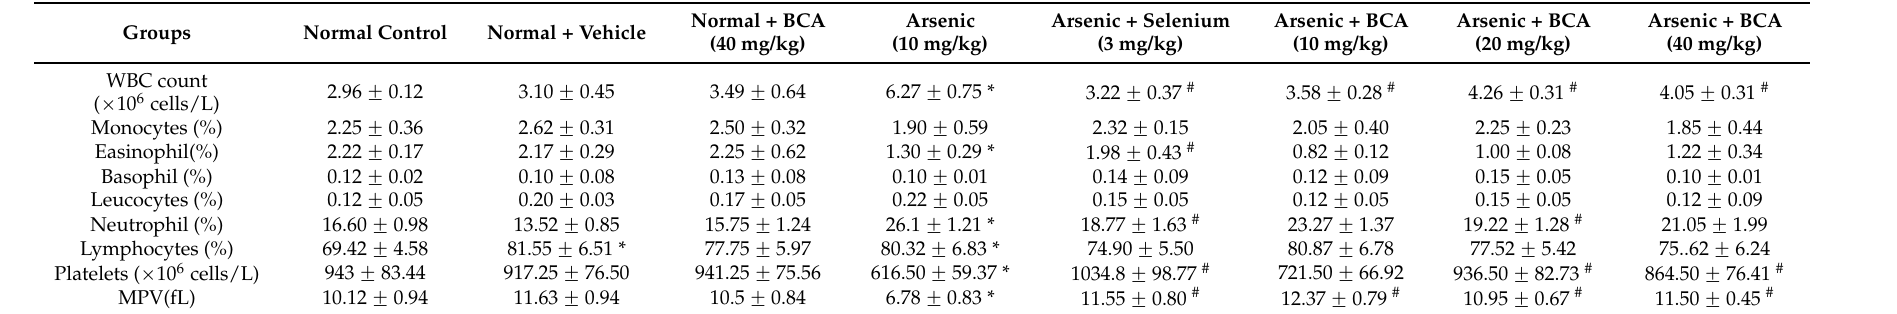
Table 4. WBC indices and platelets of normal control and experimental